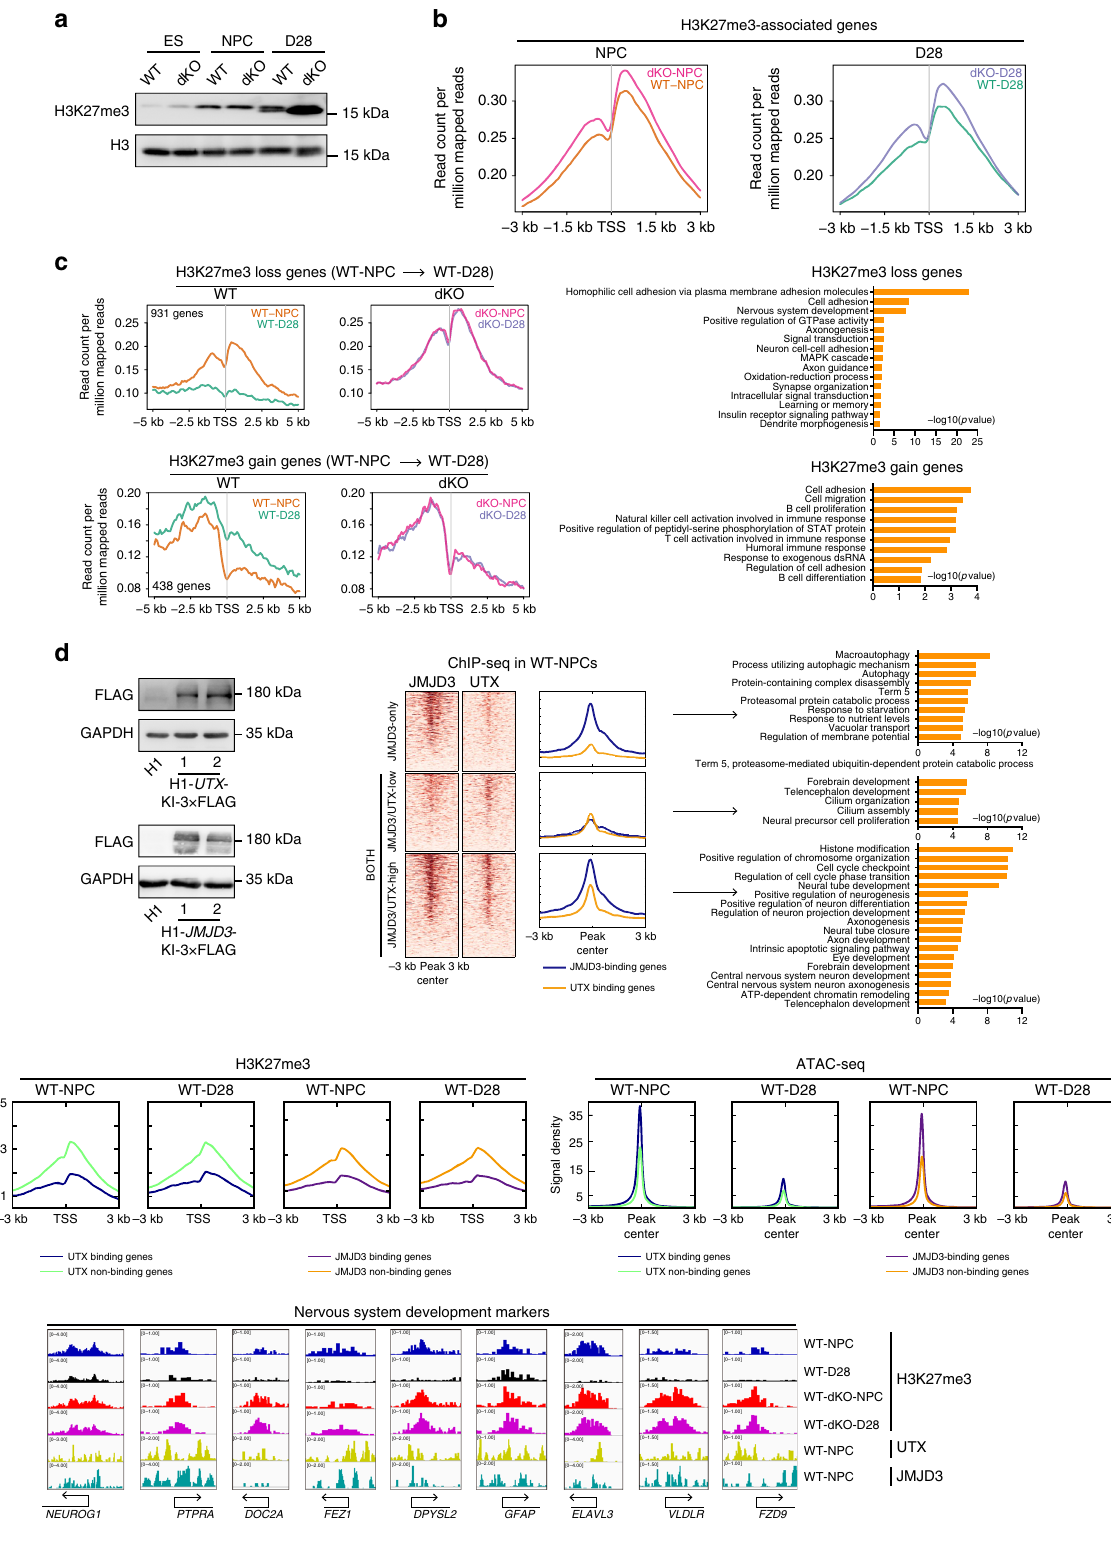
six-well plates coated with Matrigel in mTeSR1 medium with 10 μ M Y-27632 (Sigma) for 1 day. Puromycin (1 μ g mL − 1 , Gibco) was used to select positive clones. To obtain UTX and JMJD3 double knock-out (dKO) cells, the antibiotic cassette in H1- JMJD3 − / − was deleted using the Cre-LoxP system. H1- JMJD3 − / − hESCs (1 ×10 6 ) were electroporated with 0.4 mg of Cre mRNA. Then, 500 elec- troporated cells were plated on